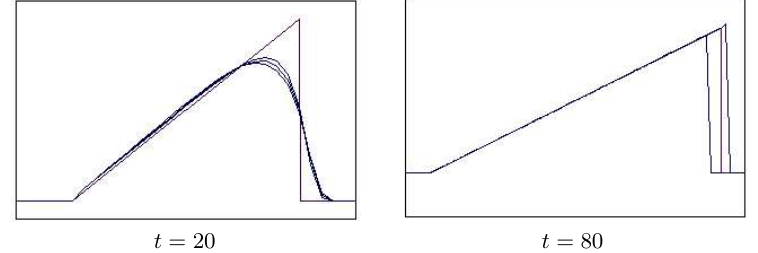
Figure 5. Numerical solution obtained using the implicit upwind scheme for 5 initial data ( (cid:13) = 0 : 1; 0 : 5; 0 : 9 )